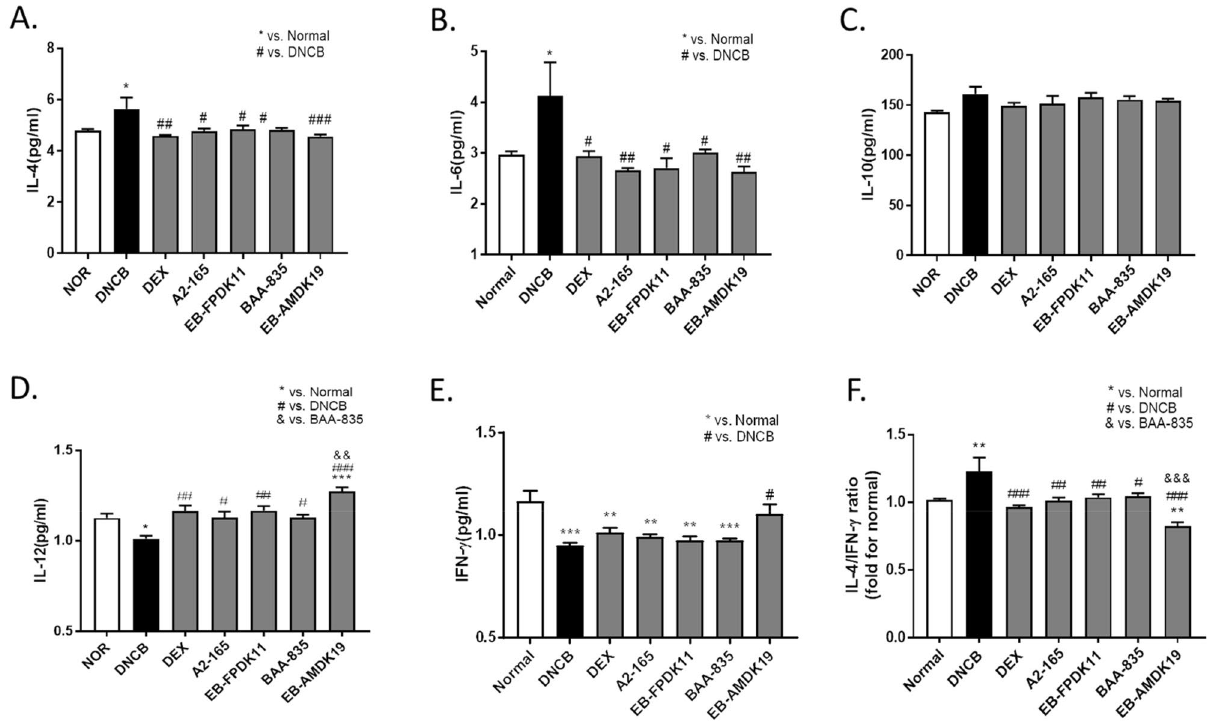
Figure 5. Oral administration of EB-FPDK11 and EB-AMDK19 attenuates Th2/Th1 cytokine imbalance in DNCB-induced AD like Nc/Nga mice. The Th2, Th1 related cytokines in serum ( A ) IL-4, ( B ) IL-6, ( C ) IL-10, ( D ) IL-12, ( E ) IFN-γ, and ( F ) IL-4/IFN-γ detected by mouse cytokine ELISA kit. Data are presented as mean ± SEM of changes in values. * P < 0.033; ** P < 0.002; *** P < 0.001, *versus normal group; # versus DNCB group; & Versus BAA-835